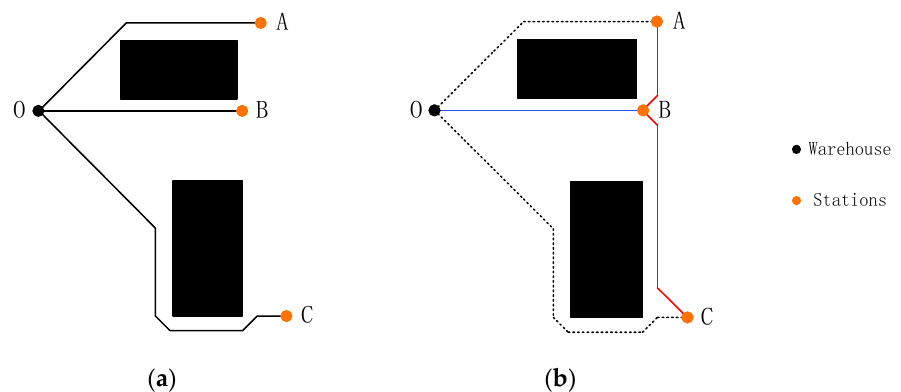
Figure 1. Schematic diagram of air-route planning result. ( a ) Single-air-route planning result. ( b ) Public air-route planning result.